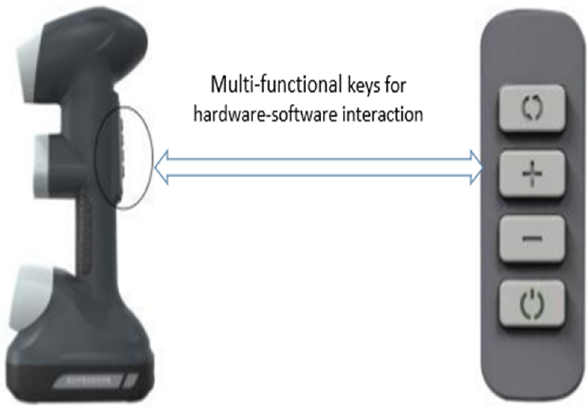
Figure 8. Handheld laser scanner.